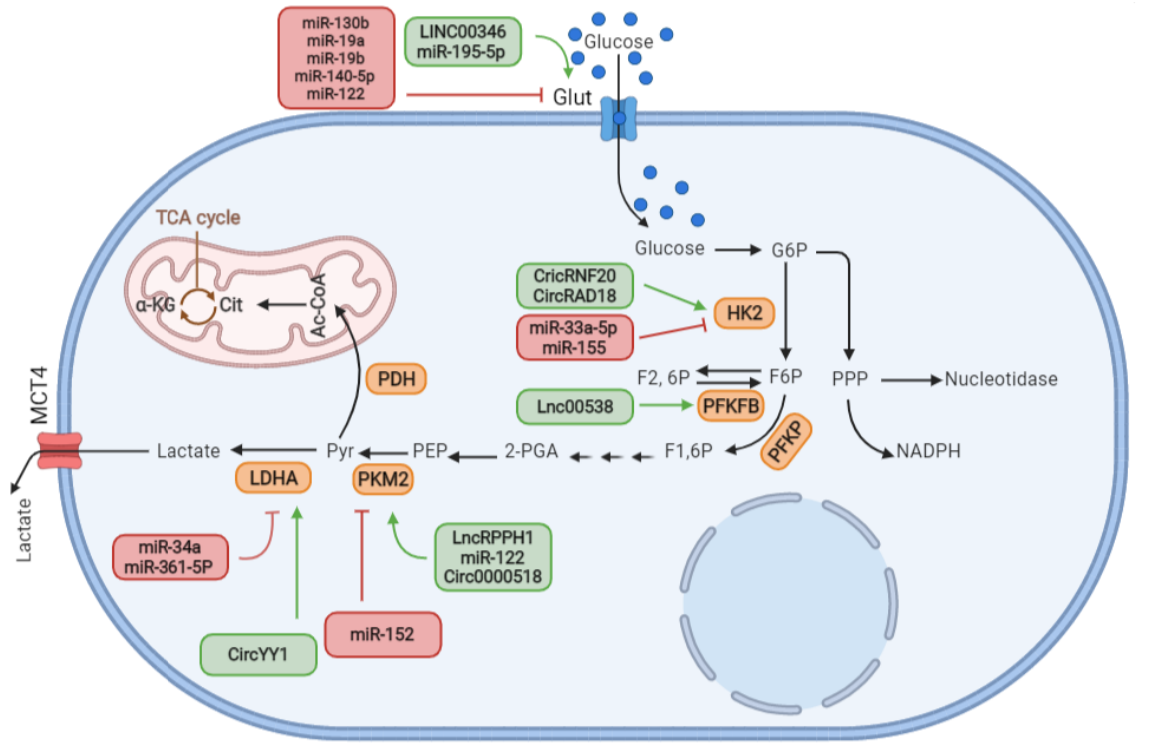
Figure 1. Simplified schematic illustration of non-coding RNAs (ncRNAs) regulatory roles in glucose uptake and glycolysis. In reprogramed cancer cells, glucose uptake is controlled by GLUTs located in the cell membrane and then converted to pyruvate under the influence of key enzymes in the glycolysis process. Interestingly, reprogramed BC cells modify glycolysis by altering the ex- pression of key enzymes and undergo the conversion of pyruvate to lactate even when the oxygen level is adequate. Different types of ncRNAs are available to use to regulate the reprogramed BC metabolism. ncRNAs have exerted their cell metabolism regulatory effects through the modulation of the expression of GLUTs and key glycolysis enzymes, such as HK2, PFKFB, PKM2 and LDHA. The steps or enzymes that are upregulated or downregulated by ncRNAs are shown by the green and red arrows, respectively. Additionally, the related ncRNAs are listed in the semicircular